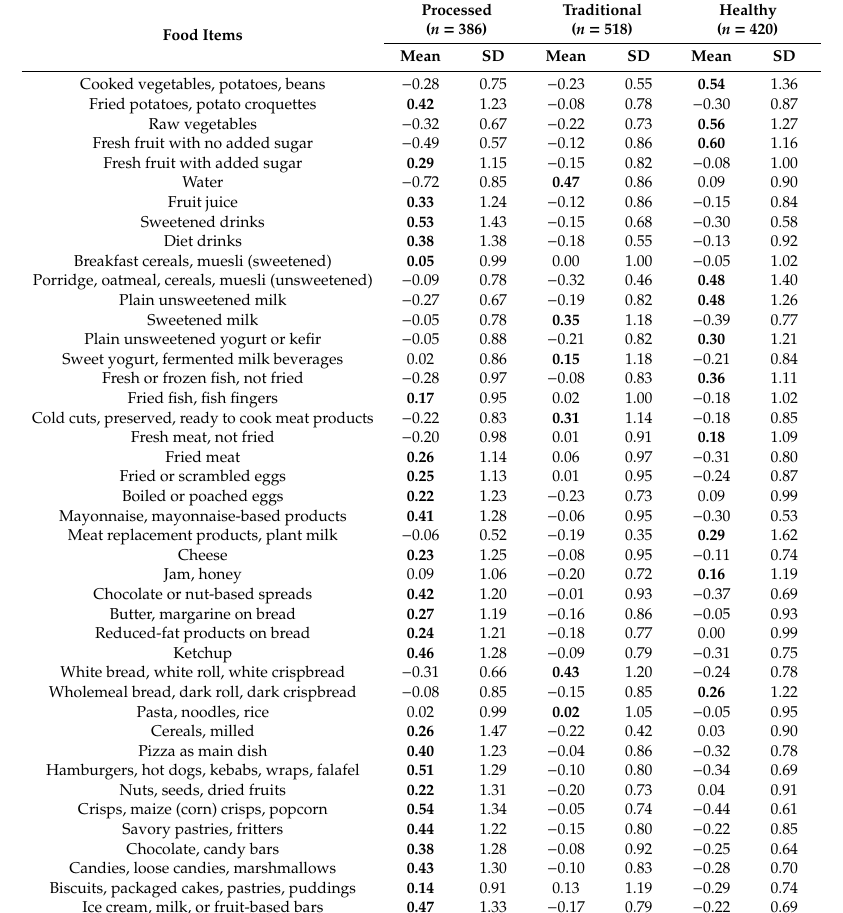
Table 1. Z-Scores for relative consumption frequencies characterizing each